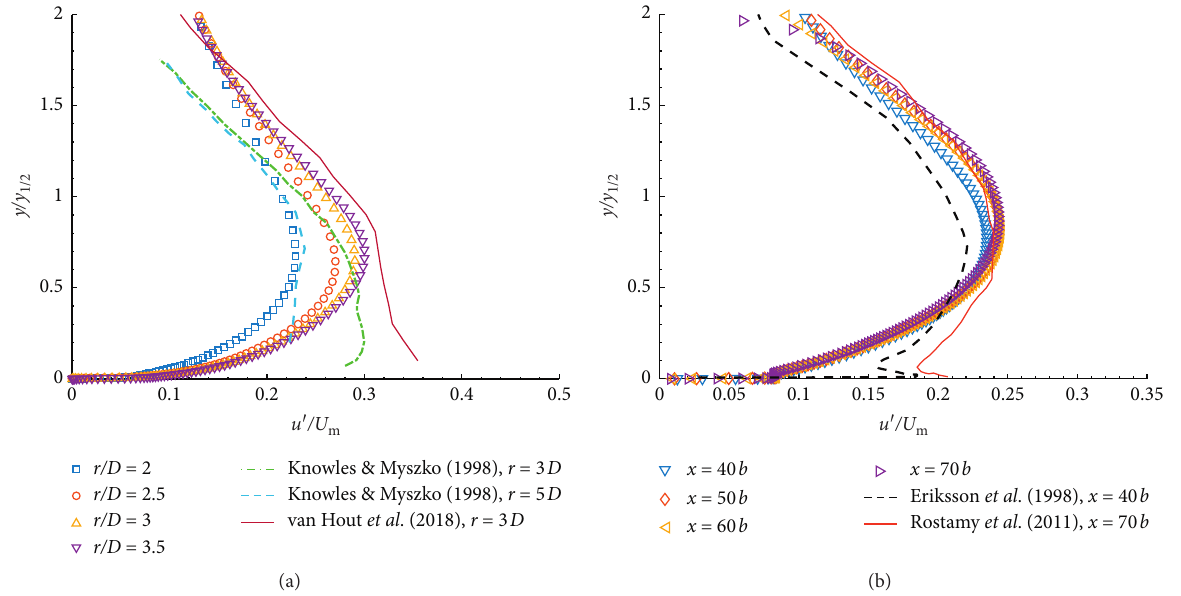
Figure 6: Profiles of streamwise RMS velocity. (a) Radial wall jet. (b) Plane wall